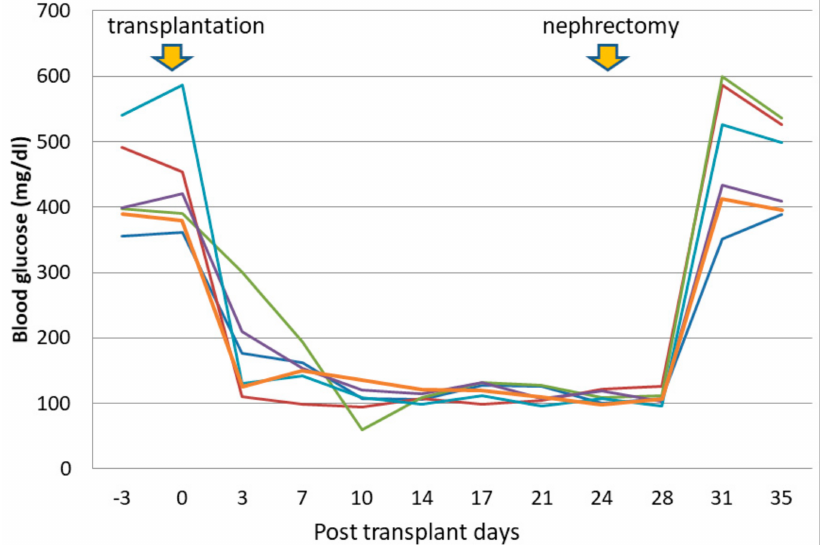
Figure 3. Effects of islet transplantation on blood glucose levels in diabetic rat ( n = 6).